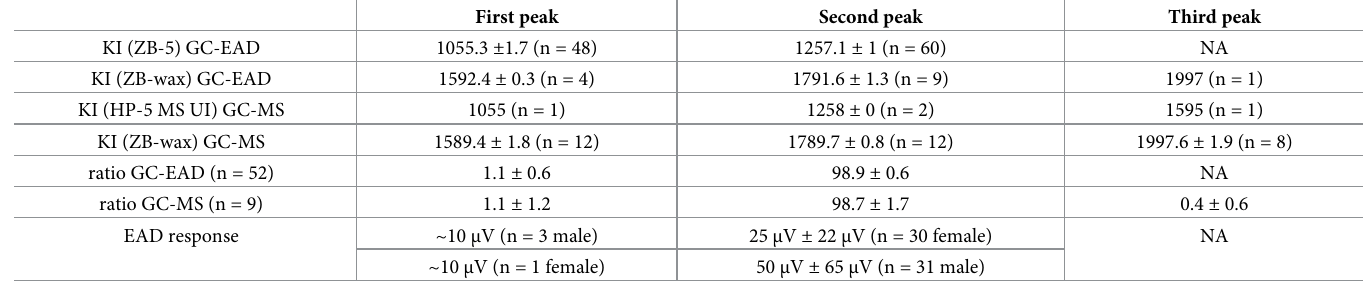
Table 1. Kovats retention index values, ratios and antennal response sizes for the three chromatographic peaks found in male extracts (mean ± standard